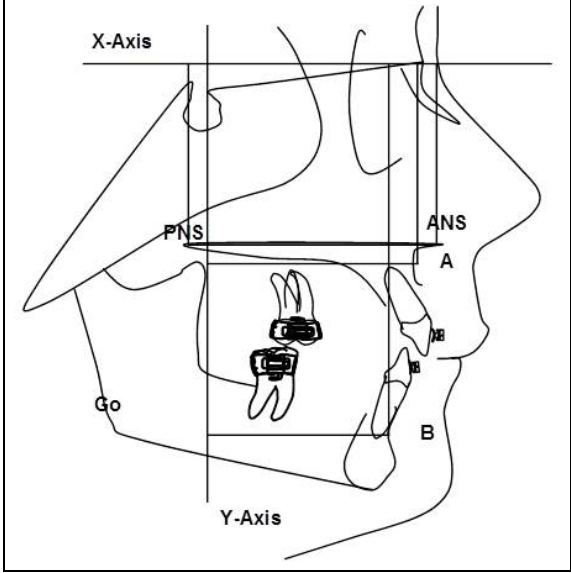
Figure 8. Angular measurements from the patient’s horizontal reference line.